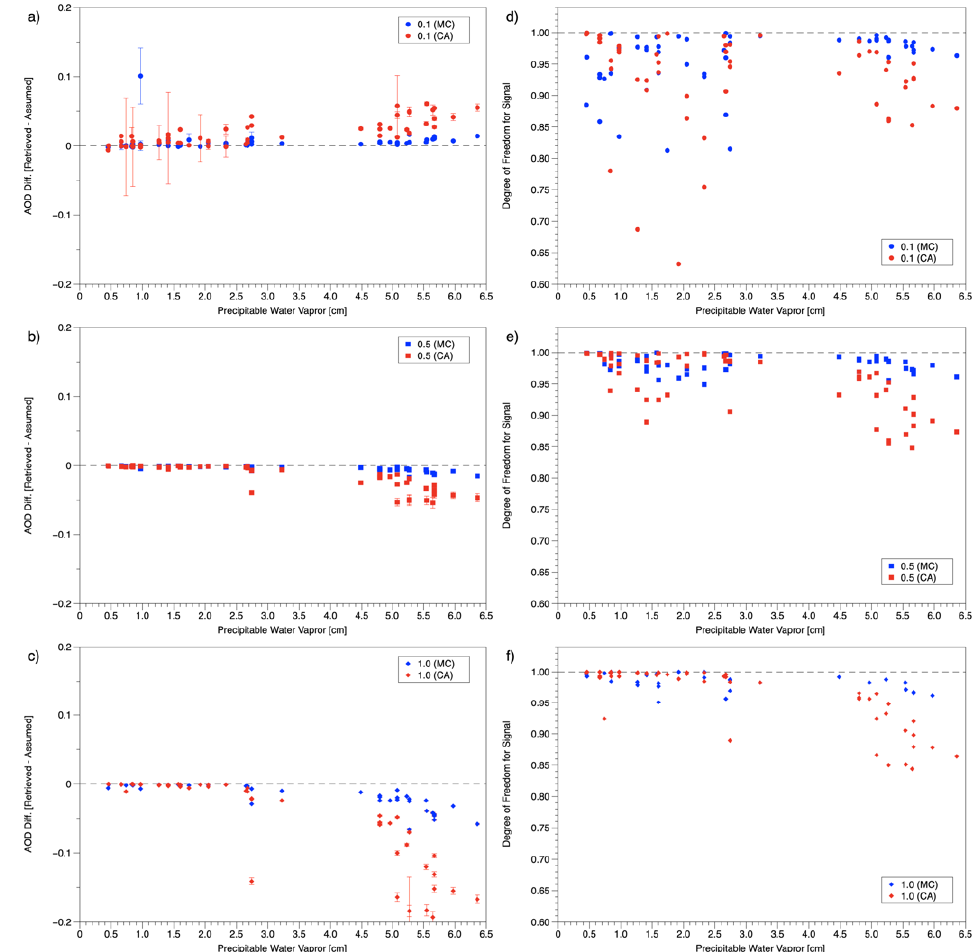
Figure 7. ( a – c ) The difference between the retrieved and assumed AOD and ( d – f ) DFS as a function of the PWV. These estimated results were acquired from the simulated radiance using the thermo- dynamic profiles from ERA-5 data, and AOD was assumed to be 0.1 (circle), 0.5 (square), and 1.0 (diamond) for the CA and MC types.